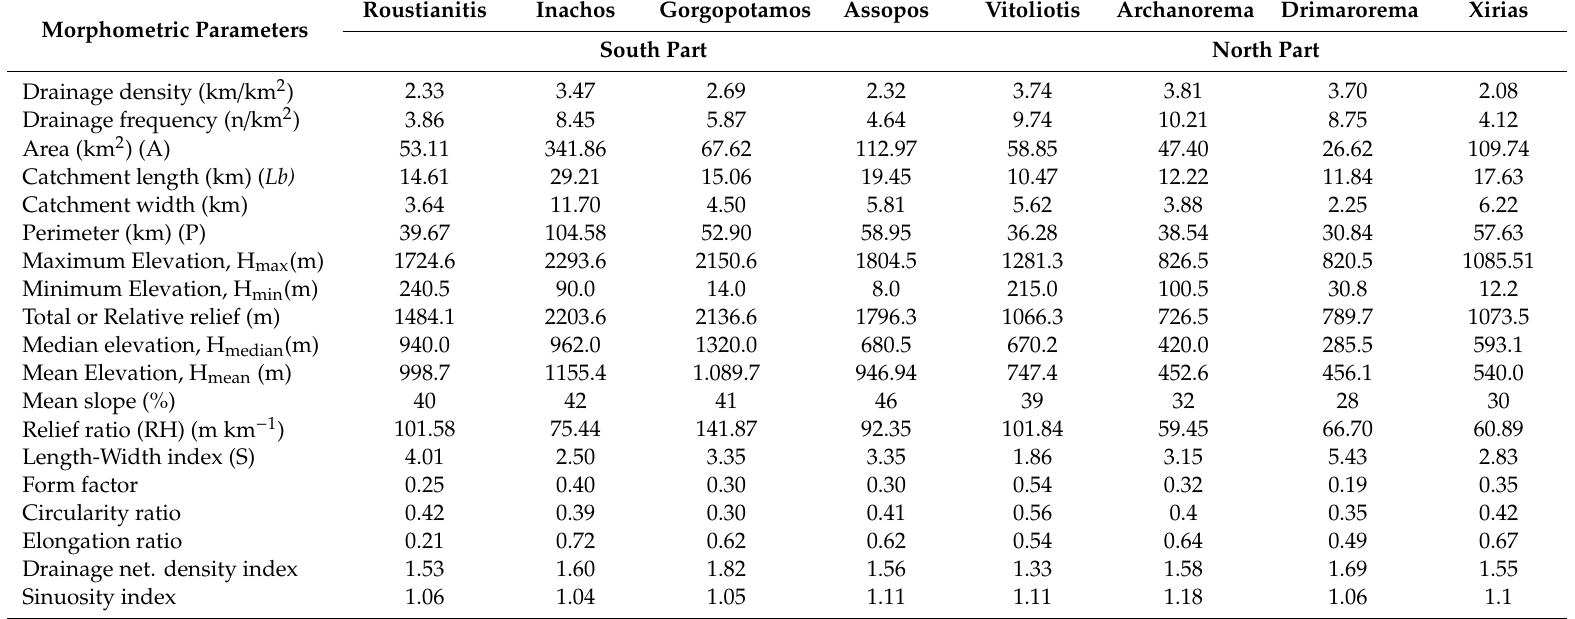
Table 1. The morphometric characteristics and parameters of the selected sub-catchments Morphometric